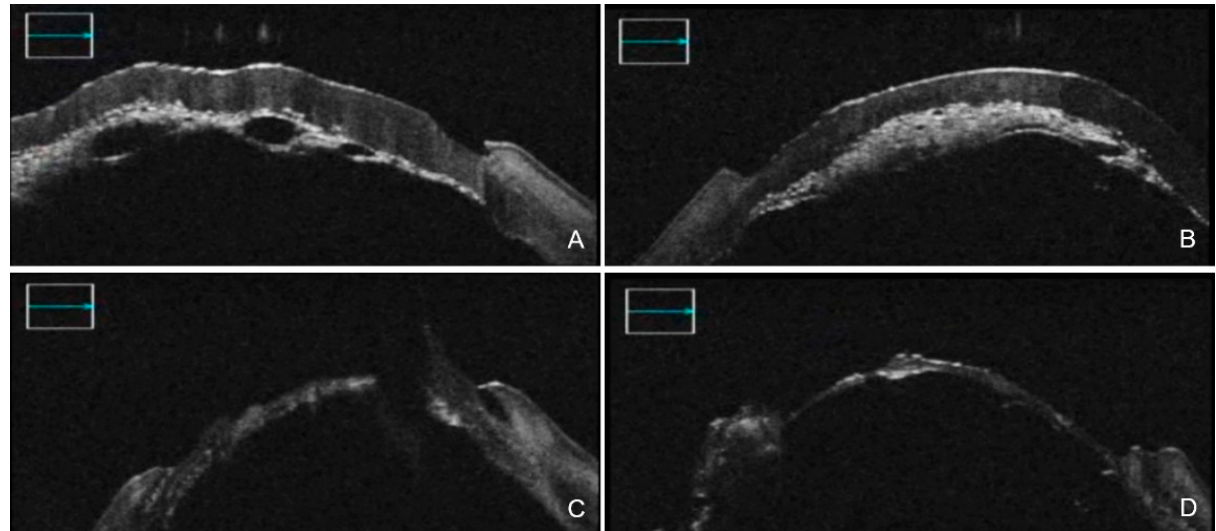
Figure 1. iOCT-assisted DALK conducted by an expert surgeon. After air injection ( A ), a failure in big bubble formation was visible thanks to iOCT, with different areas of residual adherence between posterior stroma and DM ( B ). iOCT helped the surgeon perform manual dissection of the planes ( C ) and final assessment of the uniformity of DM ( D ). iOCT = intra-operative optical coherence tomography; DALK = Deep anterior lamellar keratoplasty; DM = Descemet membrane.